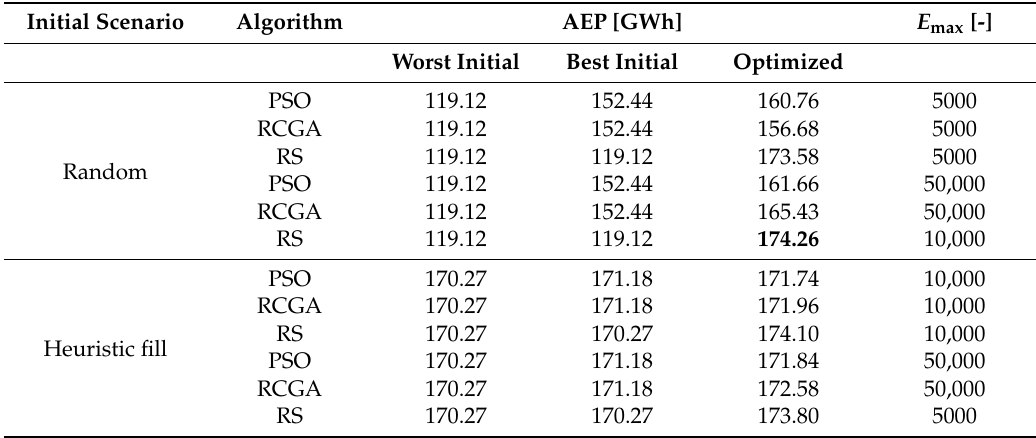
Table 4. Performance comparison of three algorithms: PSO (particle swarm optimization), RCGA (real-coded genetic algorithm) and RS (random search).